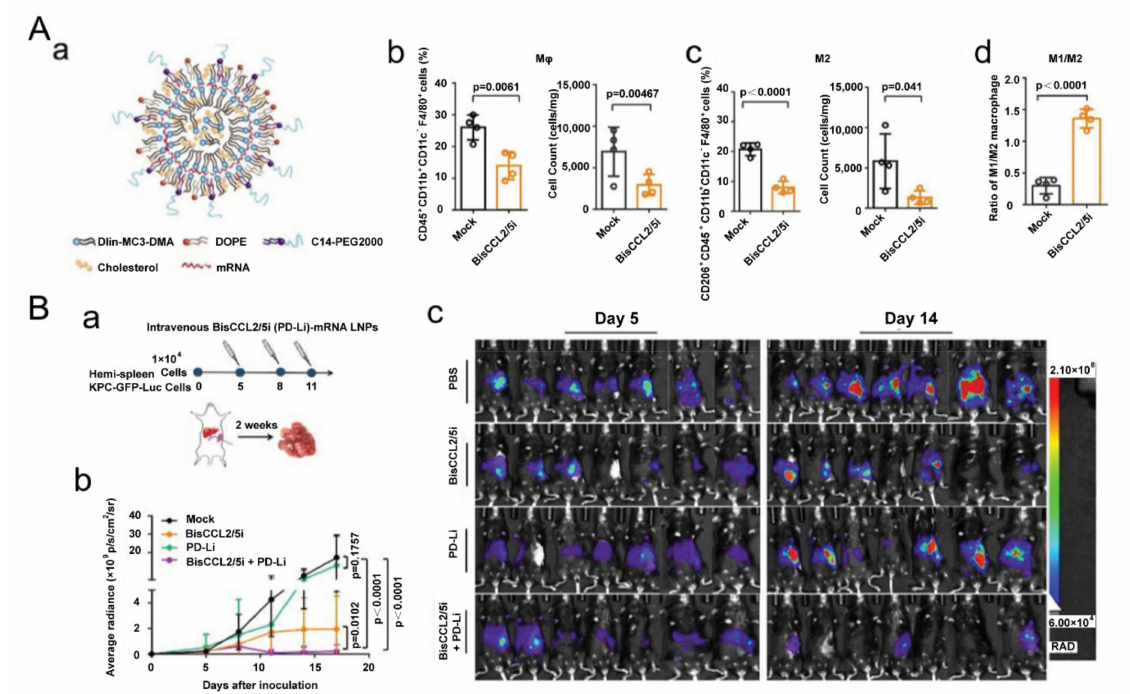
Figure 2. Lipid-based nanoparticles used for mRNA delivery of a bispecific single-domain antibody for repolarizing TAMs. ( A ) Lipid-based nanoparticles loaded with mRNA to realize CCL2 and CCL5 dual blockade reprogram TAMs. ( a ) Designs of the lipid-based nanocarriers. ( b ) The percentage of macrophages and ( c ) M2 subtypes in tumor tissue 48 h after systemic administration of the nanoparticles. ( d ) The ratio of M1/M2 in the TME. Reproduced with permission [73]. Copyright 2021 Wiley-VCH. ( B ) Dual blockade nano-strategy combined with PD-1/PD-L1 inhibition suppresses KPC liver cancer growth. ( a ) Time lines of the experiment. ( b ) Tumor growth after various treatments. ( c ) In vivo bioluminescence of tumor-bearing mice on days 5 and 14. Reproduced with permission [73]. Copyright 2021